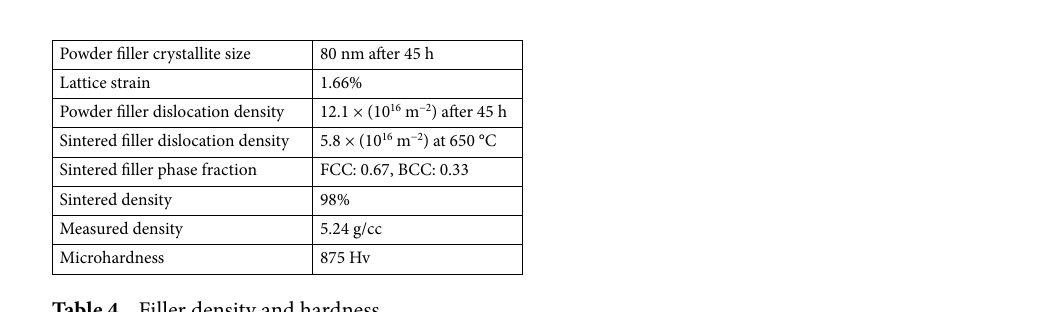
Table 4. Filler density and